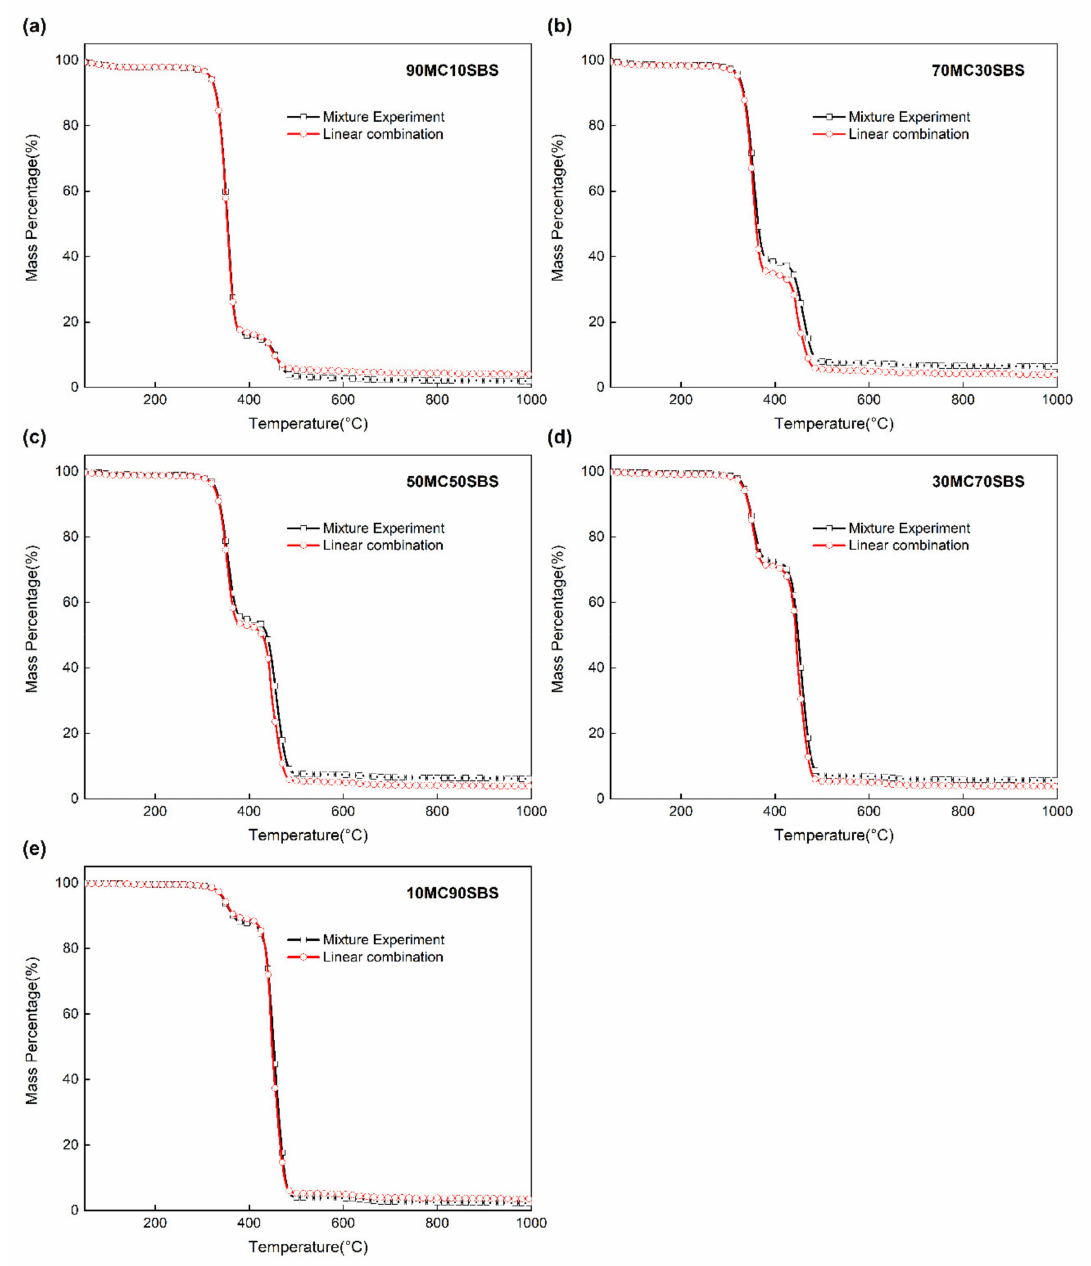
Figure 3. The TG comparison of mixture experiments and linear combinations of pyrolysis of samples with different mixing ratios. ( a ) Mixture of 90% MC and 10% SBS (90MC10SBS); ( b ) mixture of 70% MC and 30% SBS (70MC30SBS); ( c ) mixture of 50% MC and 50% SBS (50MC50SBS); ( d ) mixture of 30% MC and 70% SBS (30MC70SBS); ( e ) mixture of 10% MC and 90% SBS